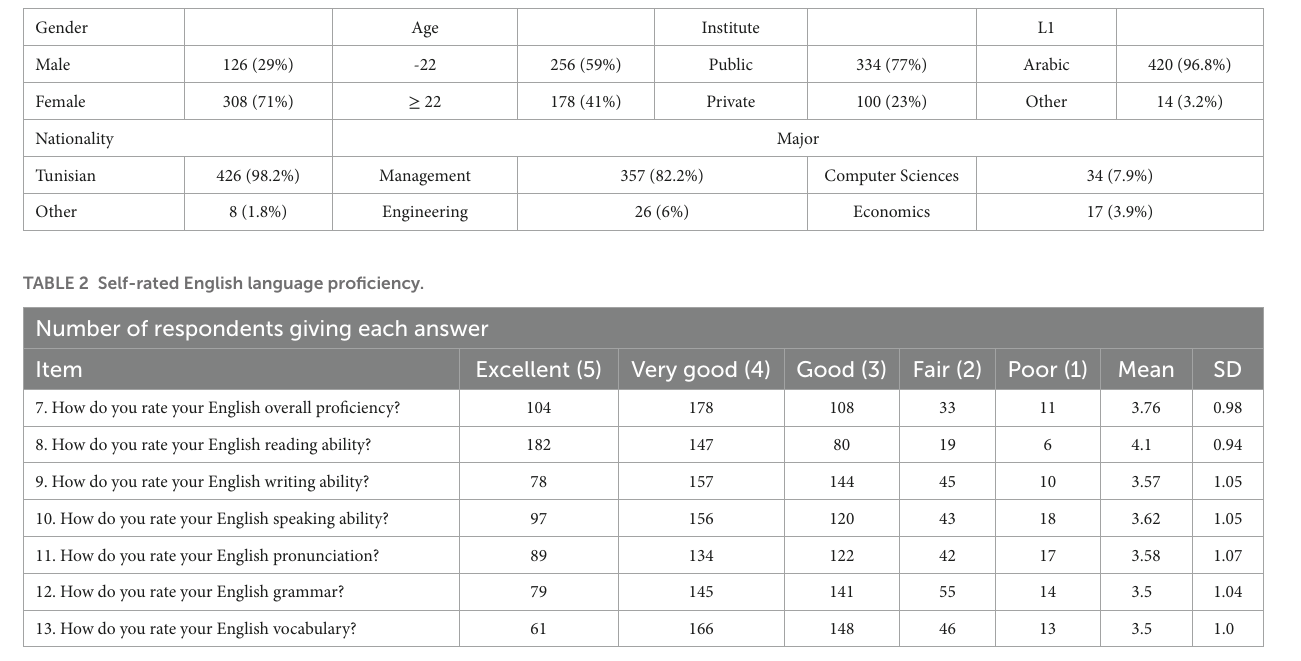
TABLE 1 Demographics (434 respondents).